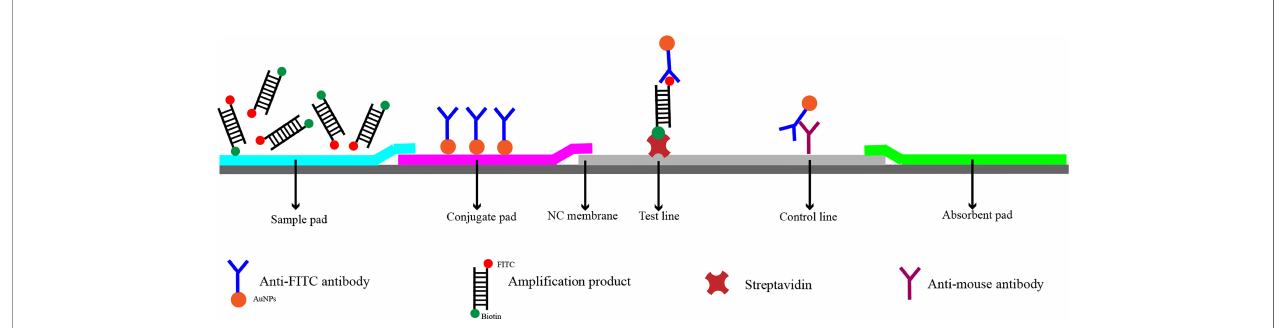
FIGURE 3 | Detection principle of RPA-LFS. The shapes and their representing molecules are listed under the strip